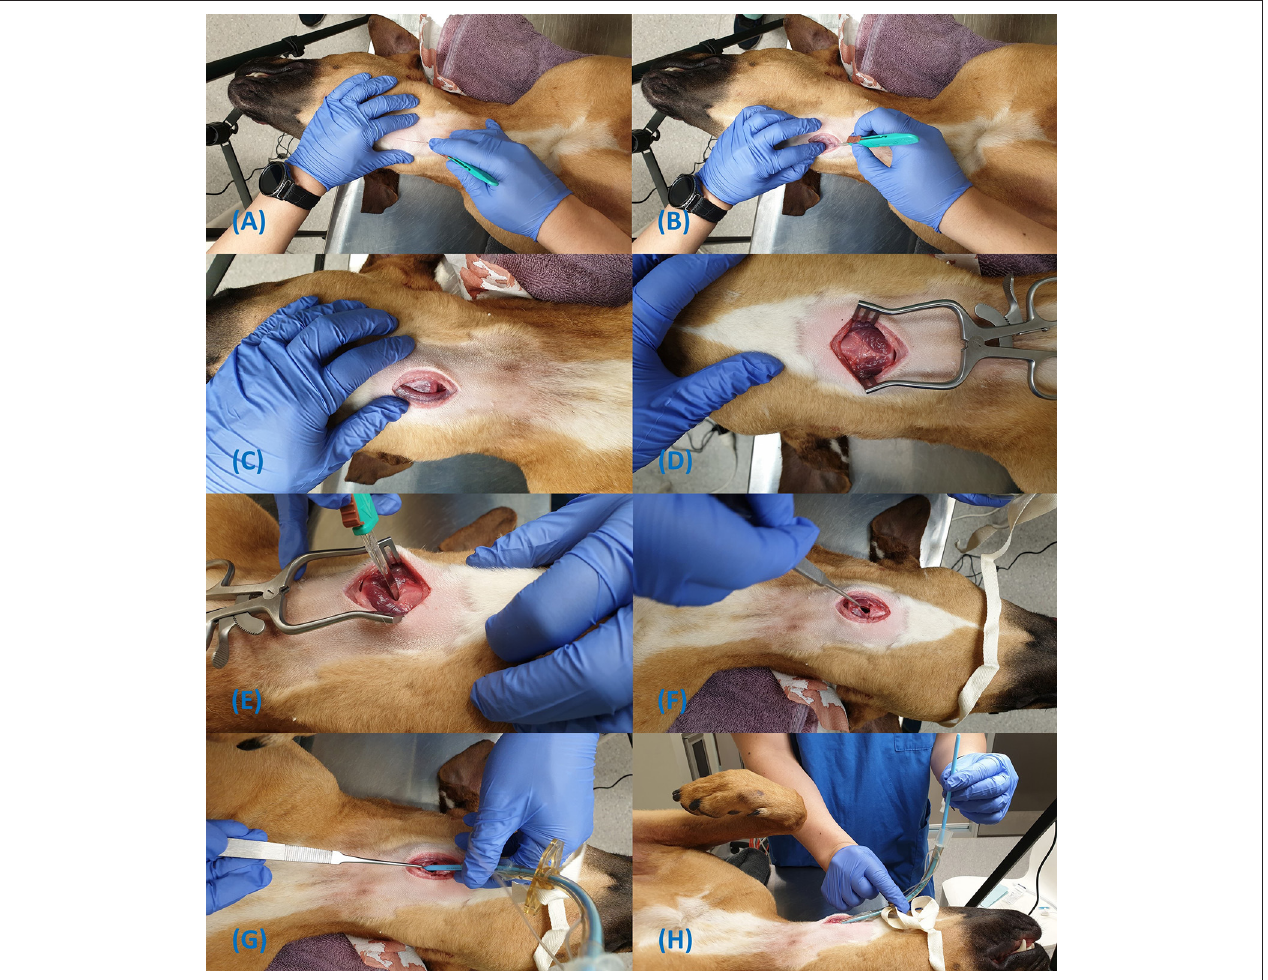
FIGURE 7 | Steps for insertion of the H&H cricothyrotomy tube using the open surgical technique (A–H)